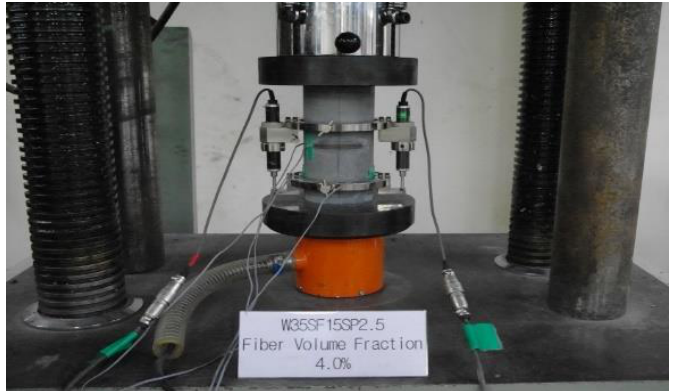
Figure 3. Experimental setup for compressive stress and elastic modulus tests.